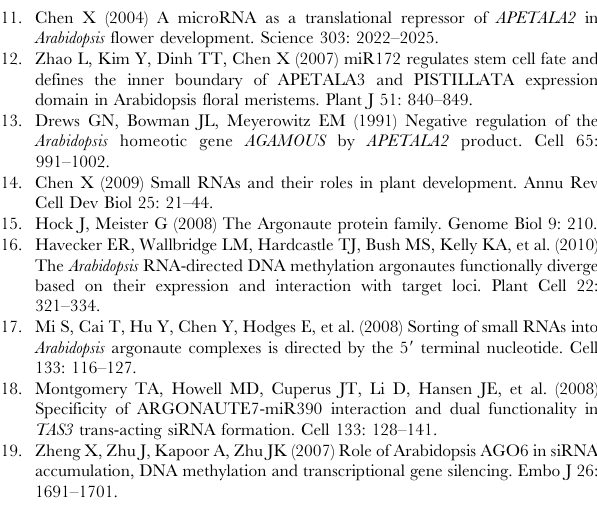
Figure S5 The expression of ZPR3 in wild type (L er ) and ago10- 13 as determined by realtime RT-PCR. Figure S6 A diagram of amiR165/166. A modified, partial pri- miR168 is highlighted in black. The amiR165 and amiR166 sequences (in green) were introduced into the pri-miR168 backbone through two rounds of PCR cloning using the Swa I and Pme I sites, respectively. The whole structure was inserted between a 2X35S promoter and a 35S terminator through the restriction sites Hin dIII and Eco RI. Table S1 Floral organ counts in various genotypes. Table S2 Sequences of oligonucleotides used in this